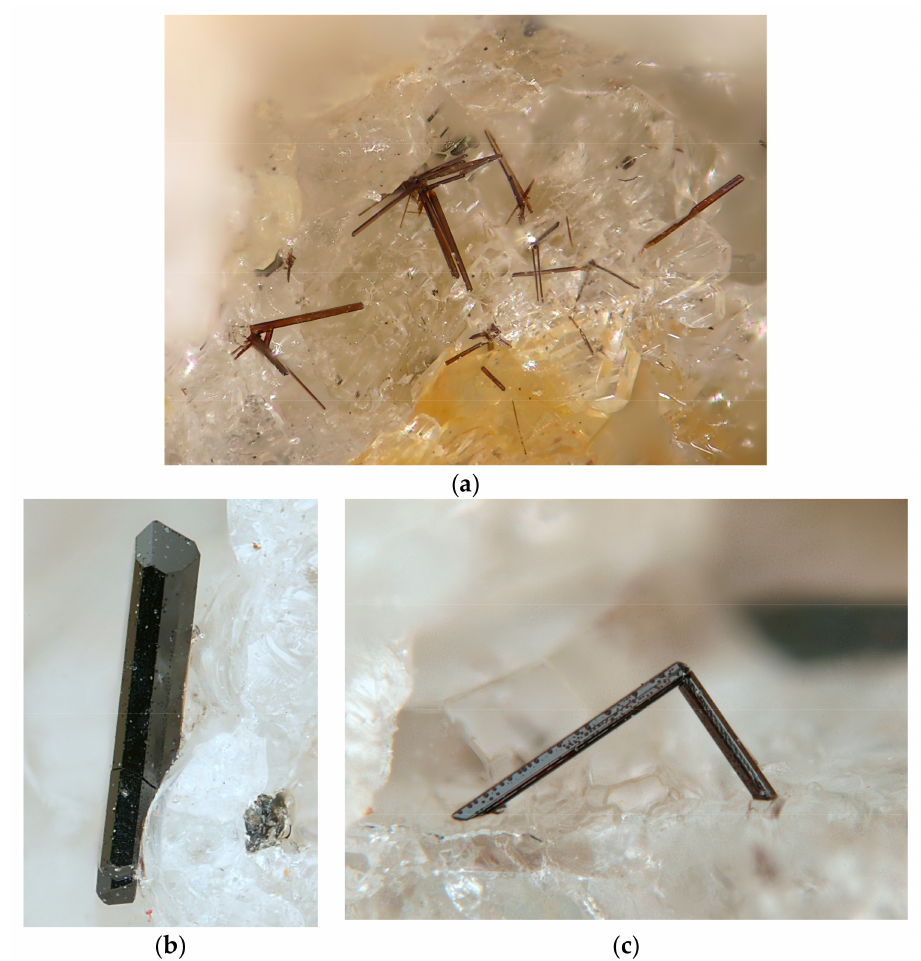
Figure 1. ( a ) Aggregates of brown nöggerathite-(Ce) crystals on sanidine. Photographer: Stefan Wolfsried. Field width: 4 mm; ( b ) Nöggerathite-(Ce) crystal on sanidine. Photographer: Marko Burkhardt. Field width: 0.5 mm; ( c ) Twin of nöggerathite-(Ce) on sanidine. Photographer: Marko Burkhardt. Field width: 1